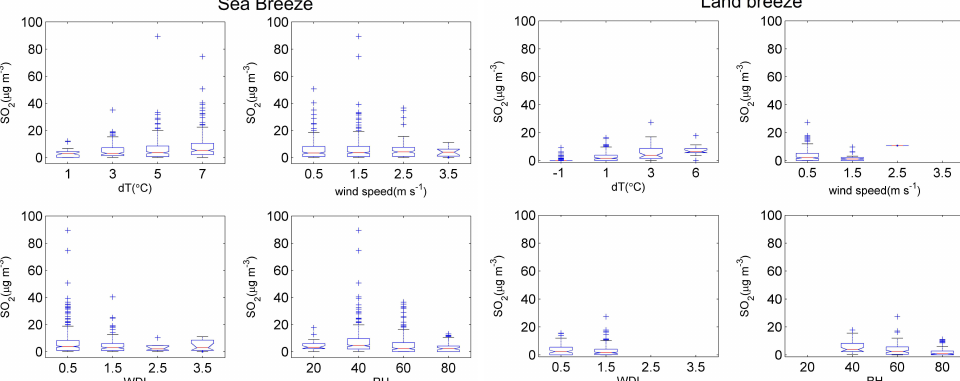
Figure 4. Box plots: SO 2 with meteorological predictors at the AMS 3 Split-1 station: the hourly air temperature difference to the temperature of the sea breeze lull (dT ( ◦ C)), wind direction index (WDI), wind speed (m s − 1 ), and relative humidity (RH (%)) for sea breeze ( a ) and land breeze ( b ). The x axis is divided into groups. The red line in the rectangle is the median, and the upper part of the rectangle corresponds to the 75% percentile and the lower to the 25% percentile. The lines outside the rectangle show the largest and smallest interval M ± 1.5 IR, where M is the median and IR the interquartile range. The crosses outside the rectangle are data out of the M ± 1.5 IR